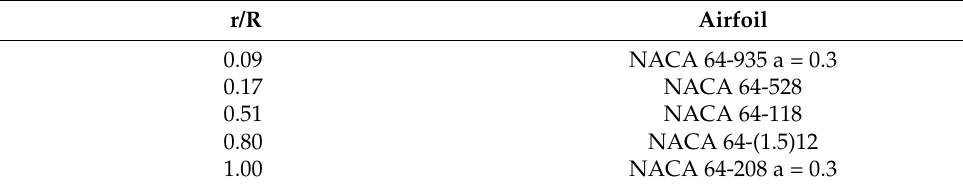
Table 2. Blade airfoils distribution for the XV-15 full-scale proprotor